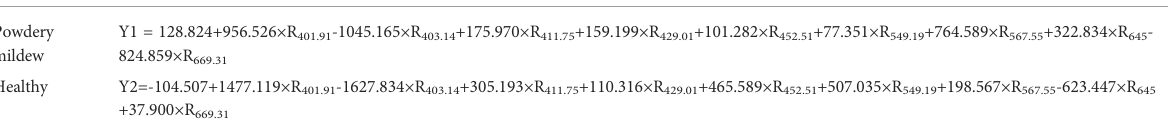
TABLE 2 Discriminant model of cucumber powdery mildew.